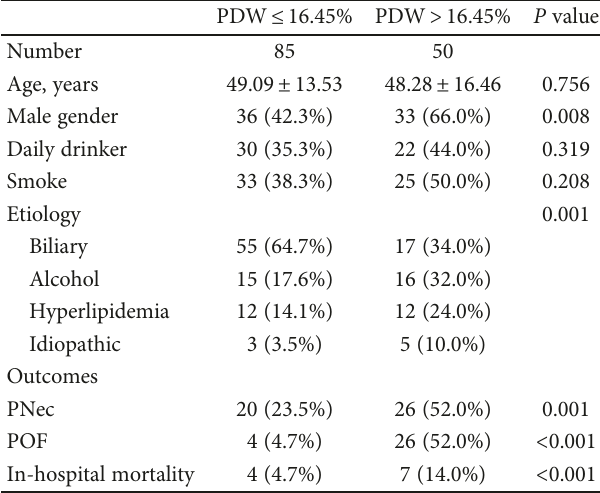
Table 1: Basic characteristic of AP patients according to PDW level (cut-o ff : 16.45%).